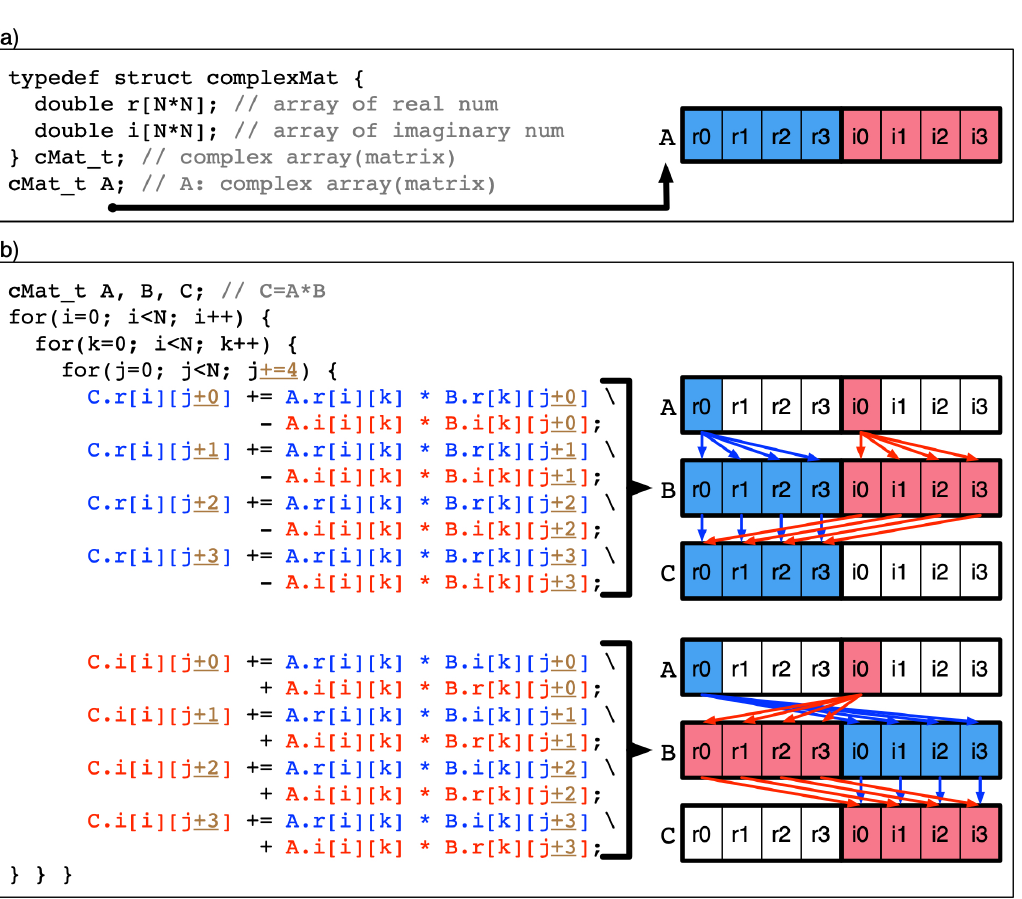
Figure 4. Matrix multiplication with SIMD (or SIMT) where two complex matrices are constructed with structures of arrays. ( a ) Matrix elements are constructed with two arrays that store real and imaginary numbers. ( b ) During multiplication of two complex matrices, elements can be accessed continuously (stride = 1), so the benefit of SIMD (or SIMT) can be fully exploited and multiplication can be done more efficiently than the case discussed in Figure